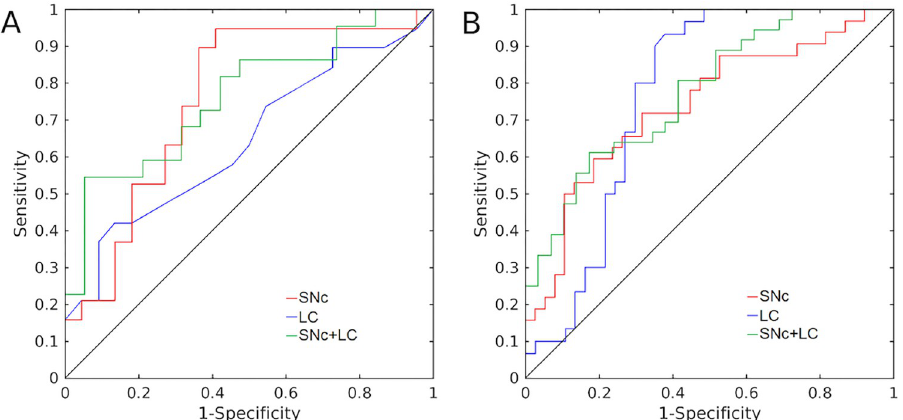
Fig 5. ROC analysis assessing performance of SNc and LC volumes to differentiate PD from controls. ROC curves for Cohort 1 and Cohort 2 are shown in (A) and (B),